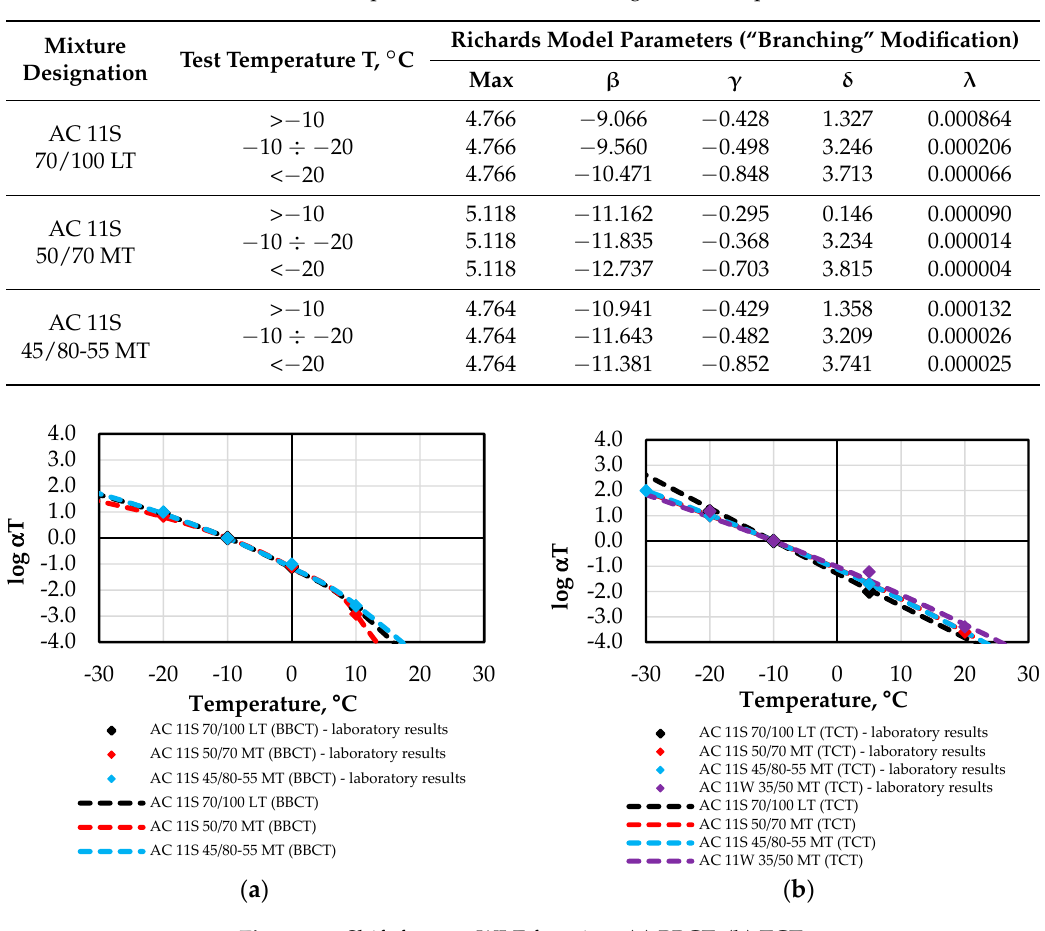
Figure 10. Shift factor—WLF function: ( a ) BBCT; ( b )